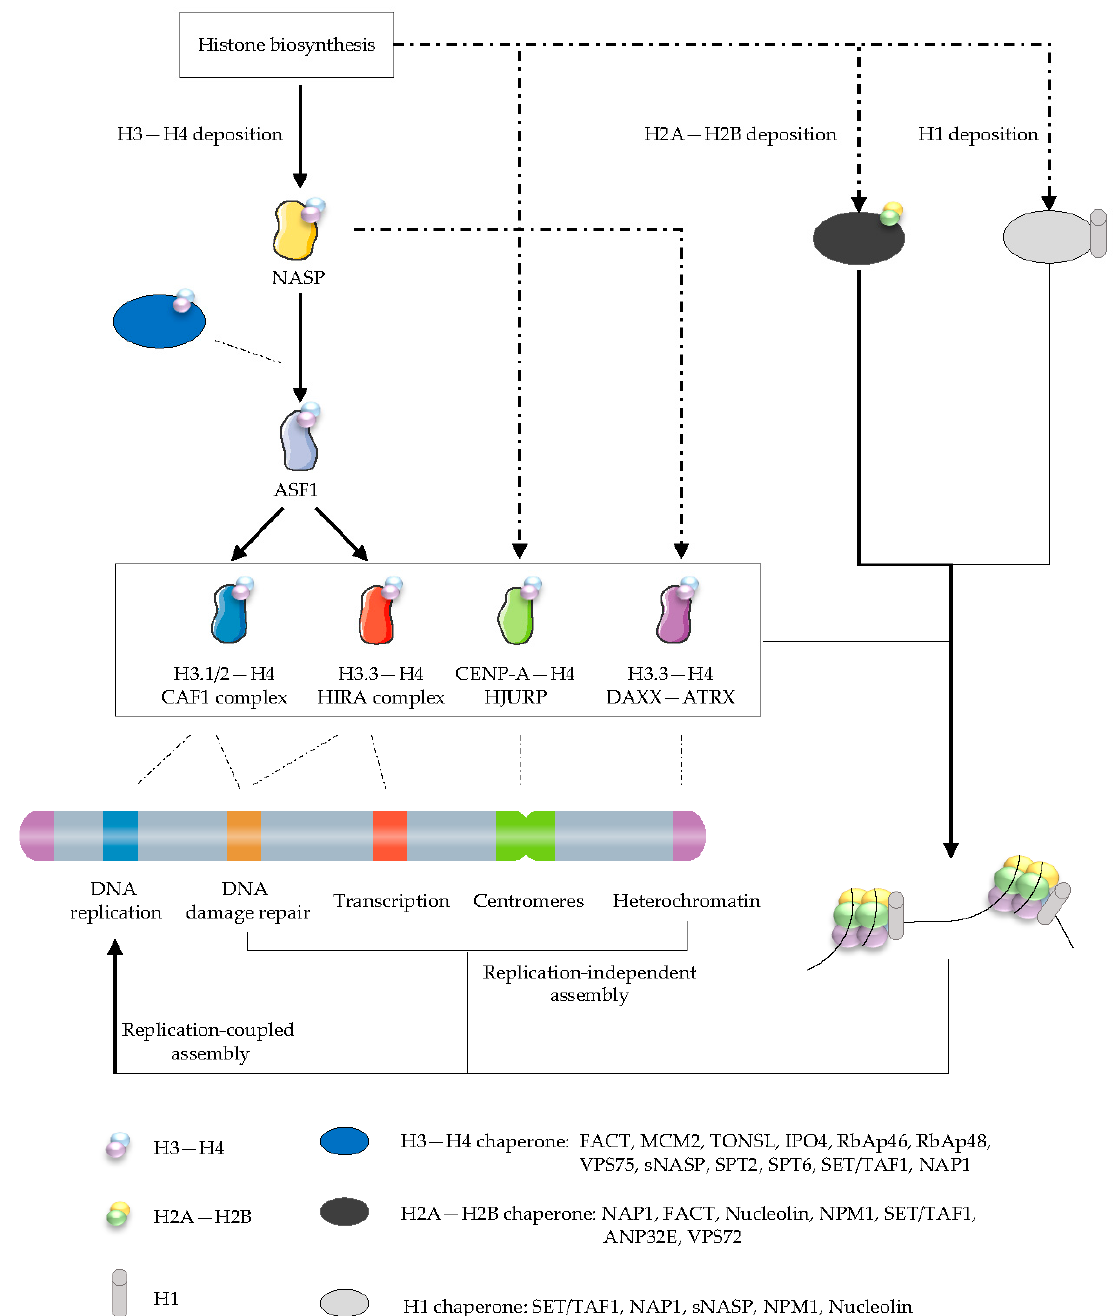
Figure 3. The histone chaperone network for histone supply. Newly synthesized histones H3–H4 and H2A–H2B interact with multiple chaperones and enzymes on their way to chromatin after synthesis. ASF1 and NASP are central chaperones in delivery of H3.1/H3.2– and H3.3–H4 dimers. The H3.1/H3.2– and H3.3–H4 dimers are shuttled by ASF1 to the CAF1 and HIRA complexes for replication-coupled and replication-independent assembly, respectively. In addition, DAXX-ATRX also deposits H3.3–H4 dimers, while HJURP deposits CENP-A–H4 dimers. Histone chaperones such as NAP1 and FACT complex handle H2A–H2B dimers. Linker histones H1 have been shown to interact with histones chaperones such as SET/TAF1, NASP, and NAP1 in the nucleus and cytoplasm, but the chronological sequence of these interactions is still mysterious. Definitions and classifications of histone chaperones are shown in Supplementary Table